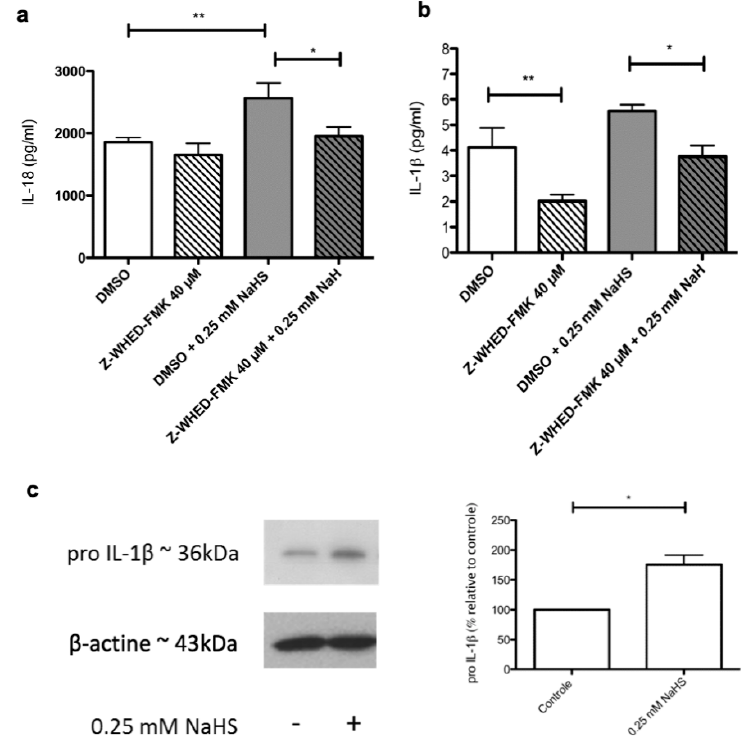
Figure 4. Role of the caspase-1 inflammasome pathway in NaHS-induced synthesis of IL-18 and IL-1 β . Human epidermal cell sheets were stimulated with NaHS at 0.25 mM in the presence of either the caspase-1 inhibitor Z-WHED-FMK 40 µ M diluted in DMSO or DMSO alone ( a , b ). Cell supernatants were then recovered 24h after stimulation and the cytokines IL-18 ( a ) and IL-1 β ( b ) were measured by ELISA. In other experiments, the amount of IL-1 β pro-form was measured by western blotting on protein extracts obtained from control or NaHS-treated human epidermal cell sheets ( c ). Experiments were performed three to five times on human epidermal cell sheets derived from one donor.